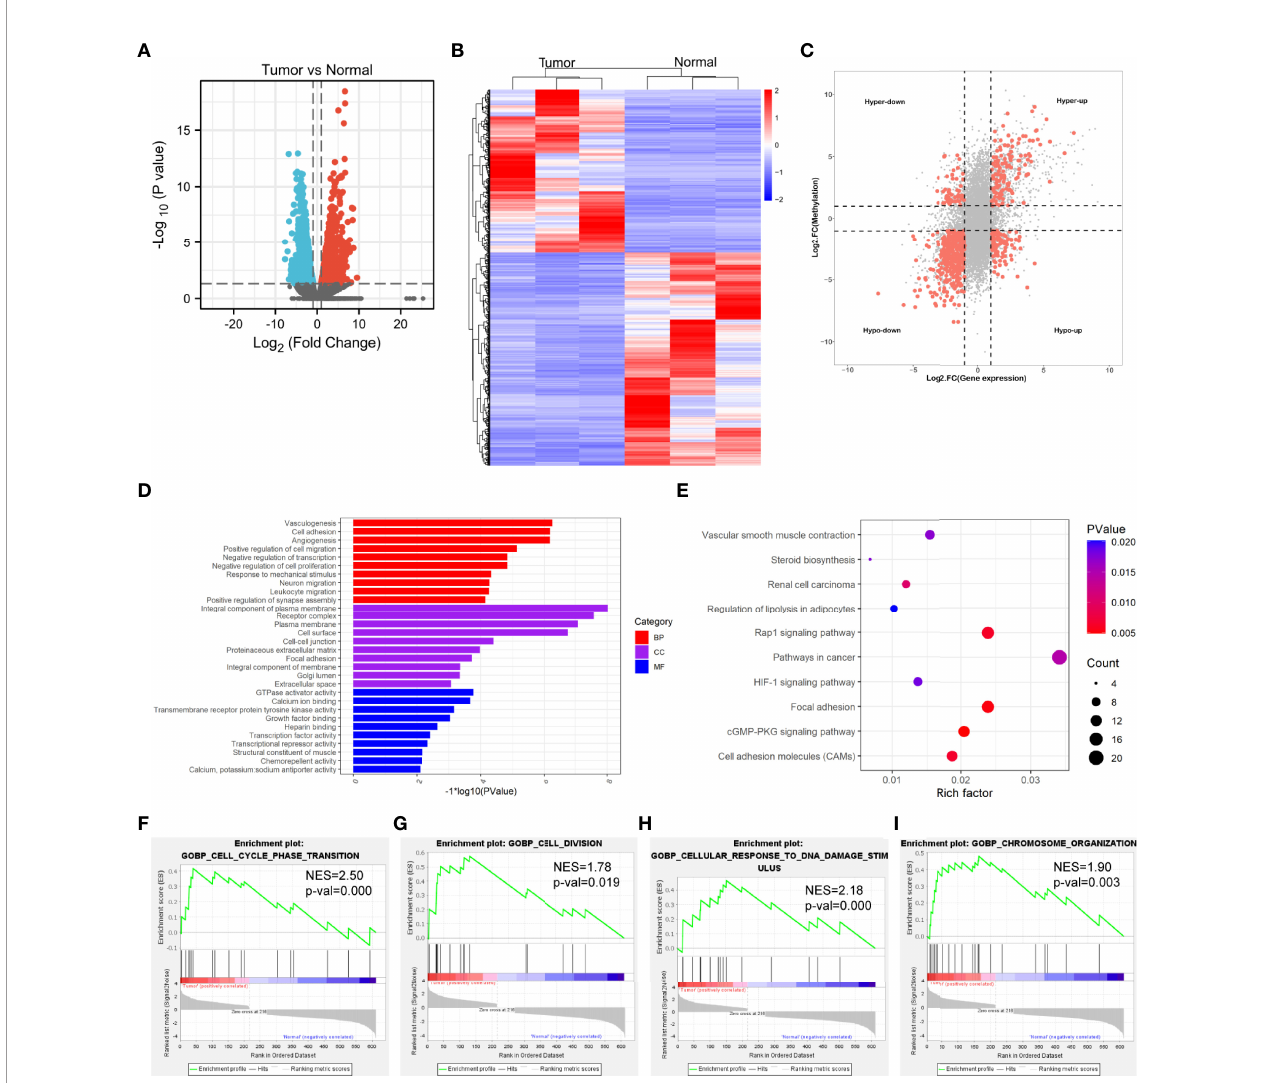
FIGURE 4 | Conjoint analysis of MeRIP-seq and RNA-seq data. (A) Volcano plots showing the differentially expressed genes in tumor vs normal. (B) Heatmap plots showing the differentially expressed genes in tumor vs normal. (C) Four-quadrant plots showing the distribution of genes with signi fi cant changes in both the m6A modi fi cation and RNA levels. (D) The top 10 GO terms of genes with signi fi cant changes in both the m6A modi fi cation and mRNA levels. (E) The top 10 KEGG pathways of genes with signi fi cant changes in both the m6A modi fi cation and RNA levels. (F, G, H, I) GSEA enrichment of genes with signi fi cant changes in both the m6A modi fi cation and RNA